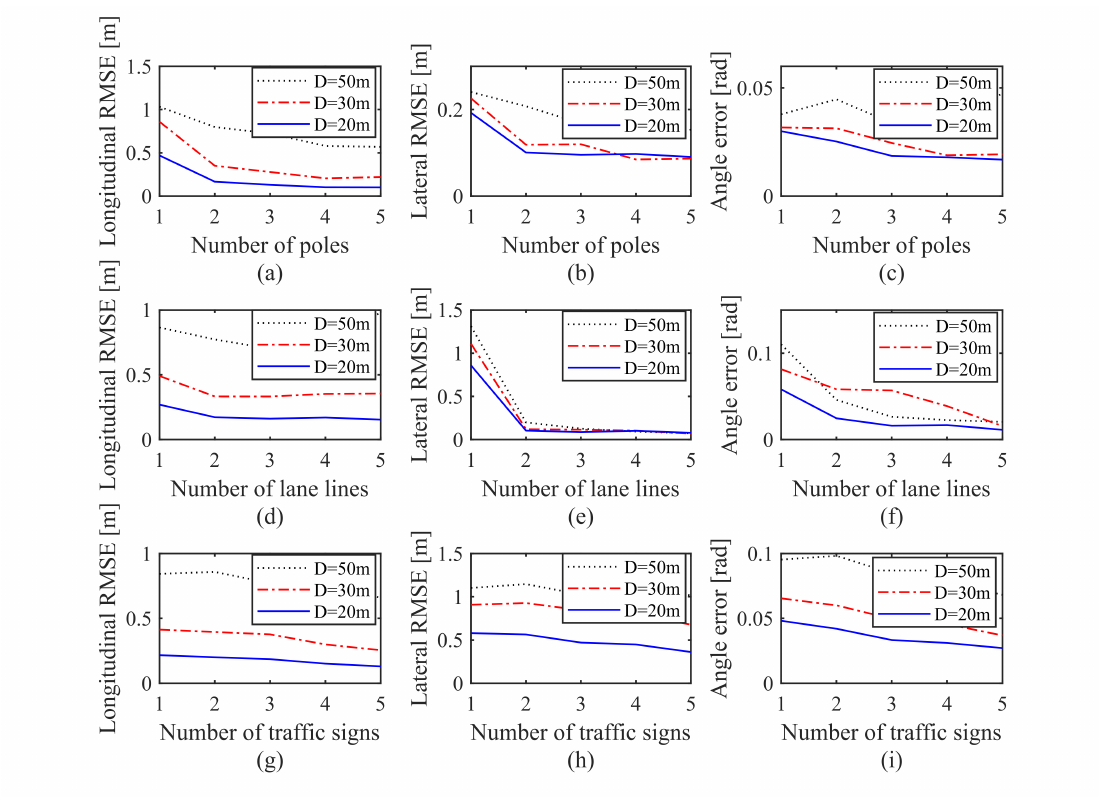
Figure 10. Localization results under different scenarios. ( a – c ): effect of vertical line features; ( d – f ): effect of horizontal line features; ( g – i ): effect of point